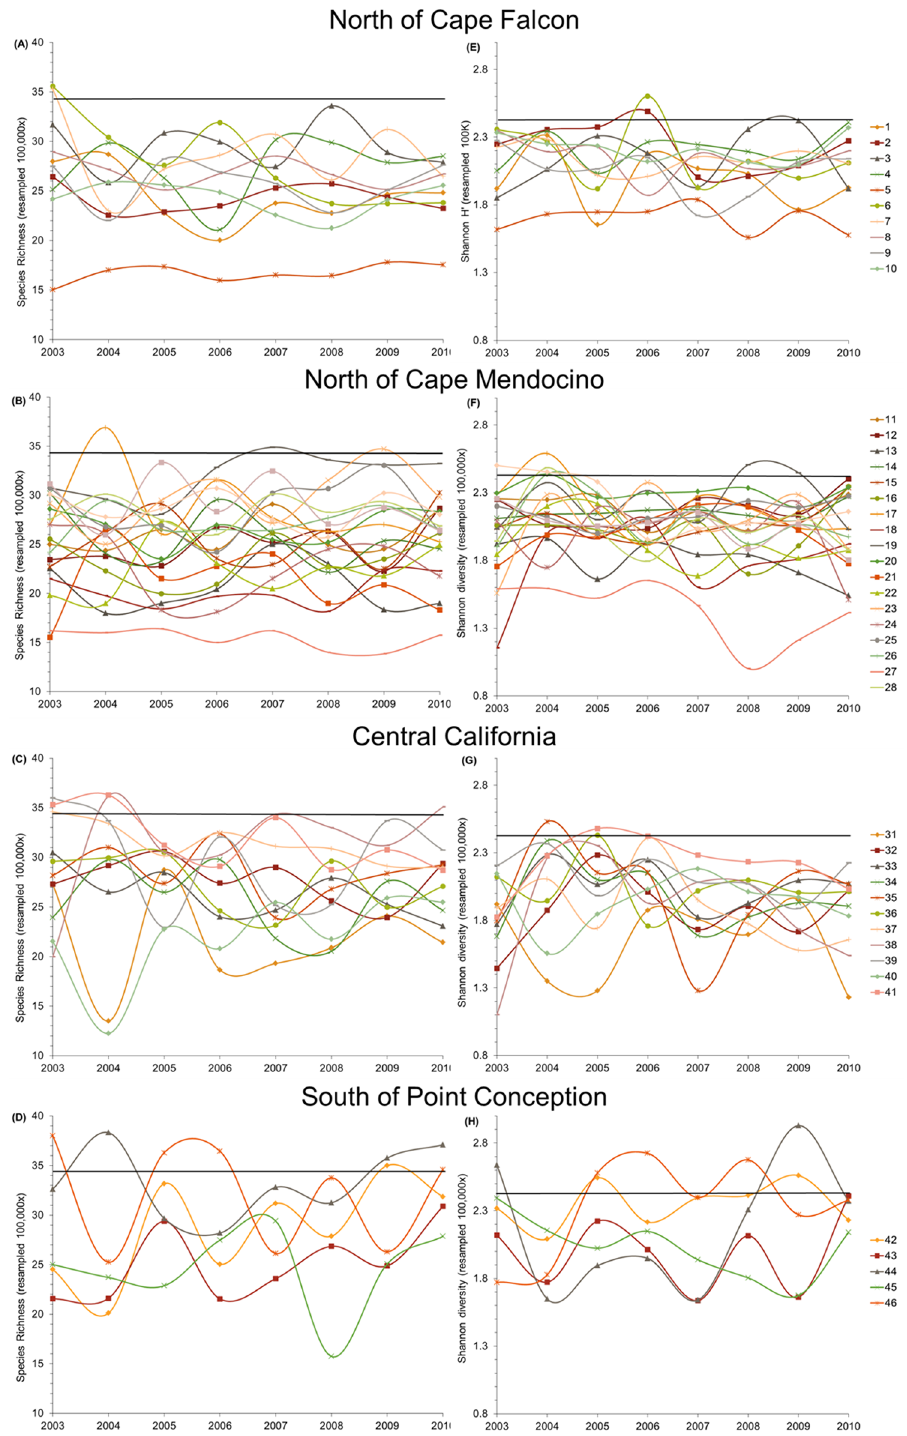
Fig 4. Temporal variability in benthic fish species richness (A-D) and Shannon diversity (H 0 ) (E-H) by grid cell by region. North of Cape Falcon (A & E), Cape Falcon to Cape Mendocino (B & F), Central California (C & G), and South of Point Conception (D & H). Horizontal black lines indicate mean biodiversity threshold for hotspot designation.